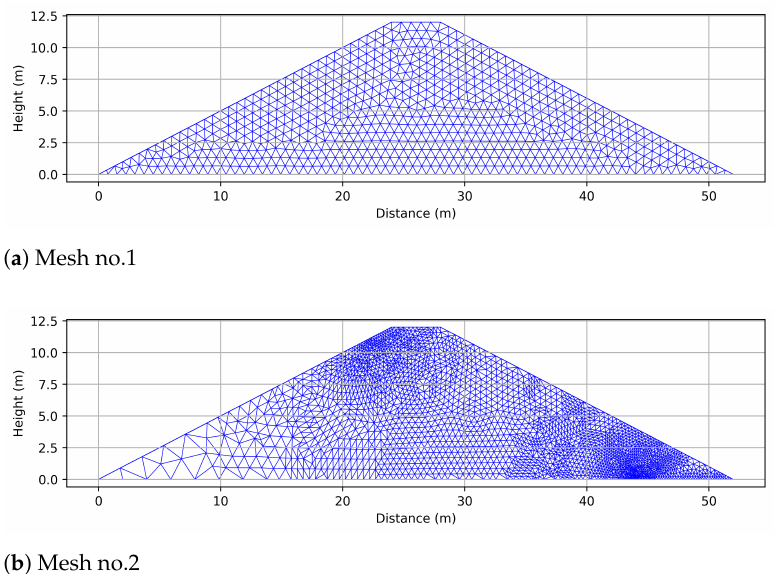
Figure 5. Meshes used in the numerical tests.